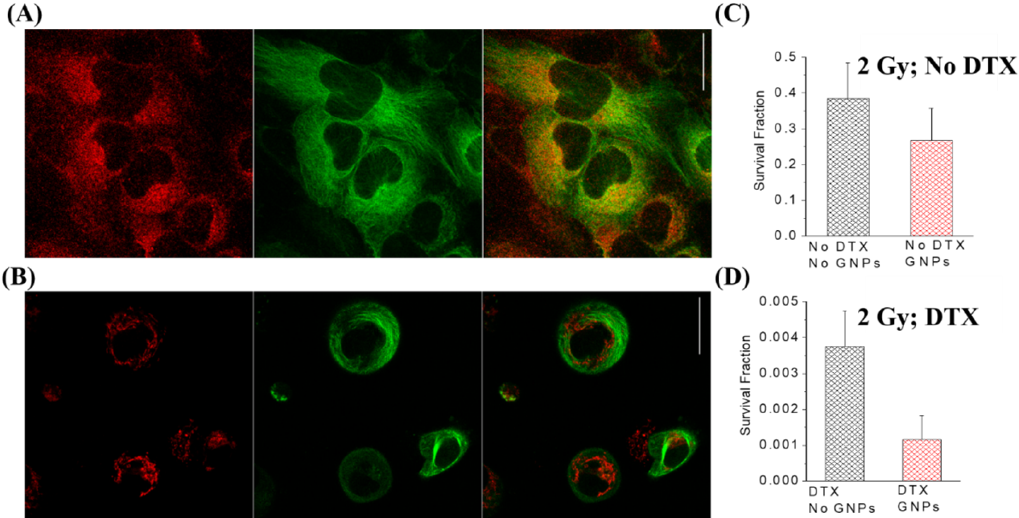
Figure 8. Docetaxel and gold nanoparticles. ( A ) Confocal imaging of GNPs (labelled in red) and the microtubule (MT) structure (labelled in green) in HeLa cells. ( B ) Confocal imaging of GNPs and MTs after treatment with 50 nM of DTX. ( C ) Radiosensitization of GNPs without DTX. ( D ) Radiosensitization of GNPs with 50 nM DTX, showing a synergistic effect. Scale bar is 25 µm. Reproduced with permission from [160] . Copyright 2020 British Journal of Radiology.